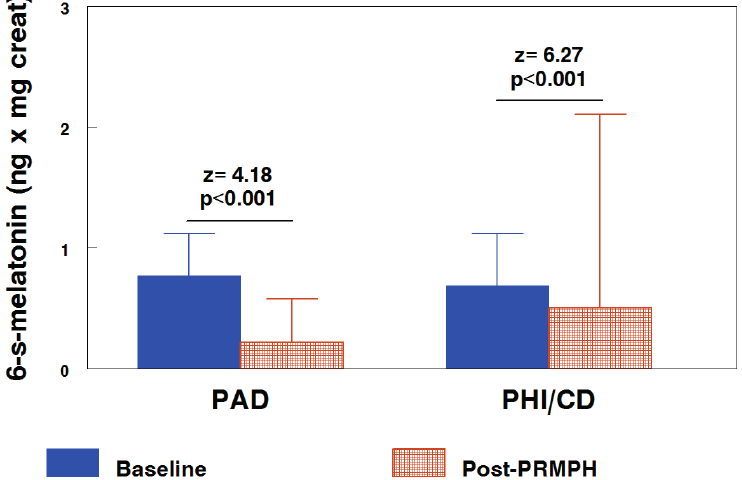
Figure 2. 6-Sulphatoxy-melatonin nocturnal excretion, by subtypes and time, in comparisons adjusted by age and sex. PRMPH, prolonged release